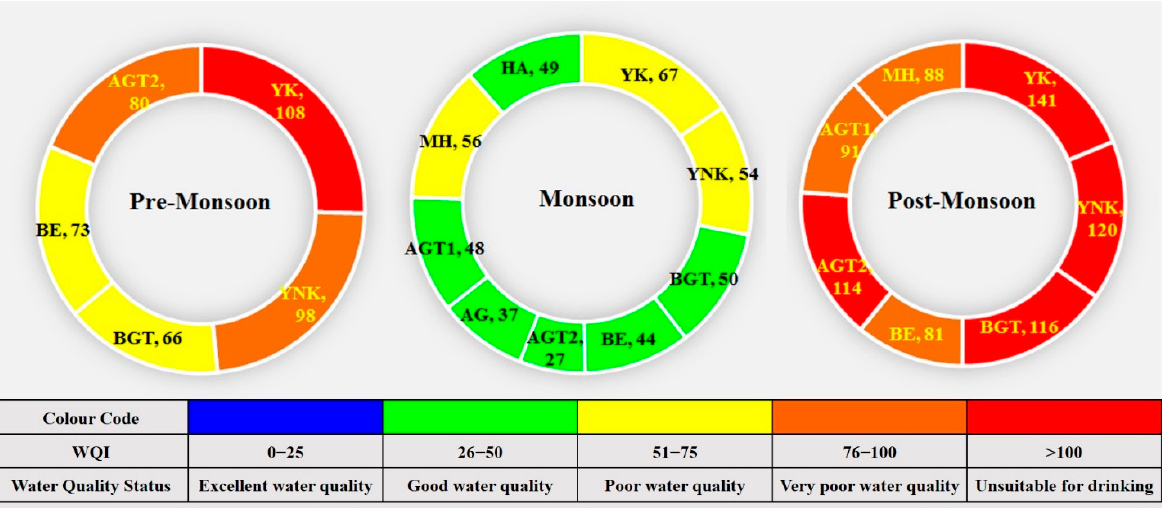
Figure 7. WQI of monitored streams during pre-monsoon, monsoon, and post-monsoon seasons.